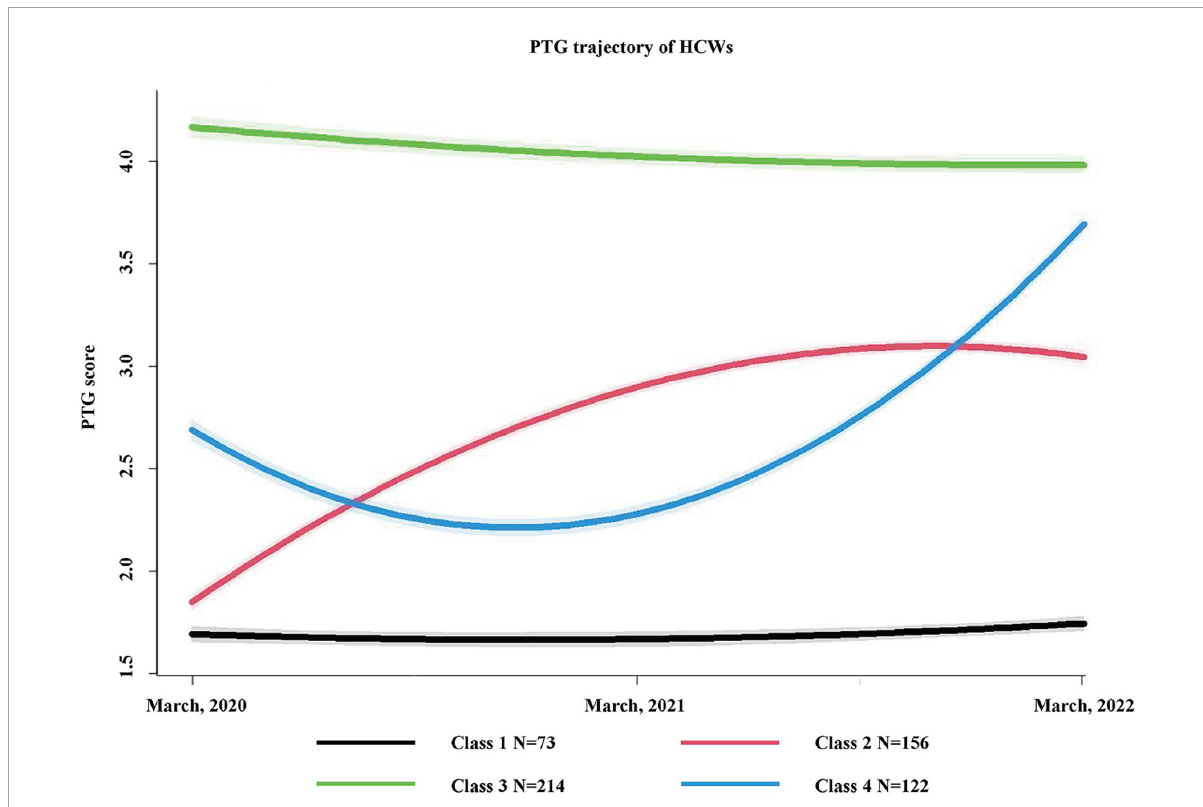
FIGURE2 Trajectories of PTG among HCWs from 2020 to 2022. The figure shows trajectories of PTG scores in these 2 years after COVID-19 outbreak among 565 health care workers. Shading around the lines represent confidence bands for the calculated trajectories.